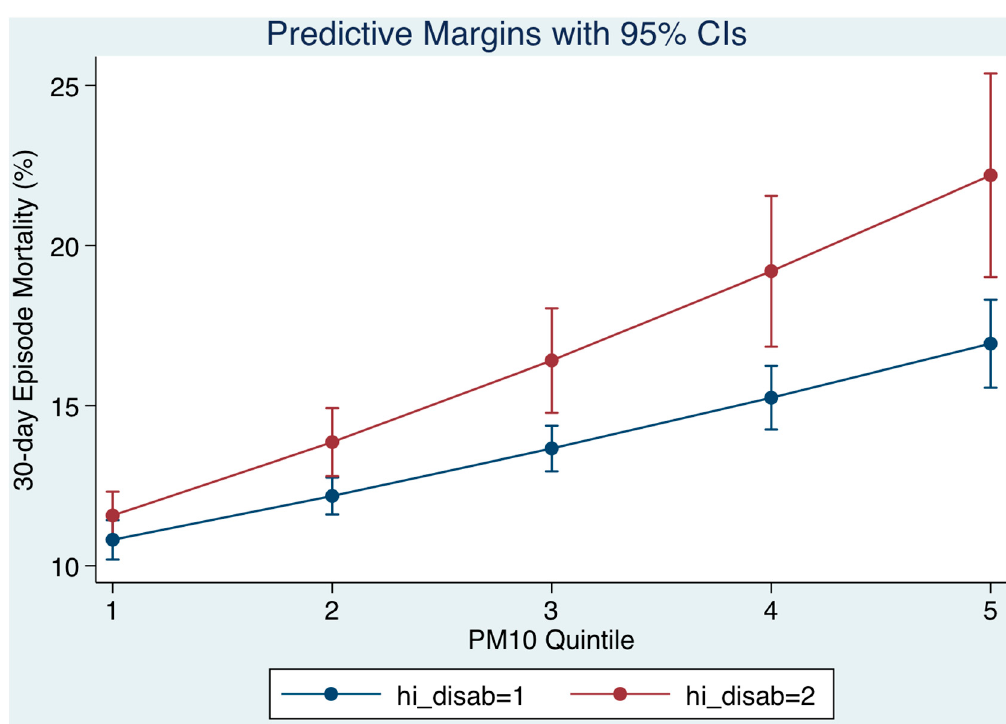
Figure 4. The 30-day in hospital mortality related daily particulate matter (PM 10 ) levels by quintiles to the 30-day in-hospital mortality and adjusted for chronic disabling disease and other outcome predictors. Disabling disease was classified with scores of 1, 2, 3, and 4+ based on the number of organ systems involved; the cut point between less or more was >3. At higher PM 10 mass concentration quintiles (level of PM 10 on day of admission), the 30-day mortality progressively increased but was higher for patient with more disabling disease.